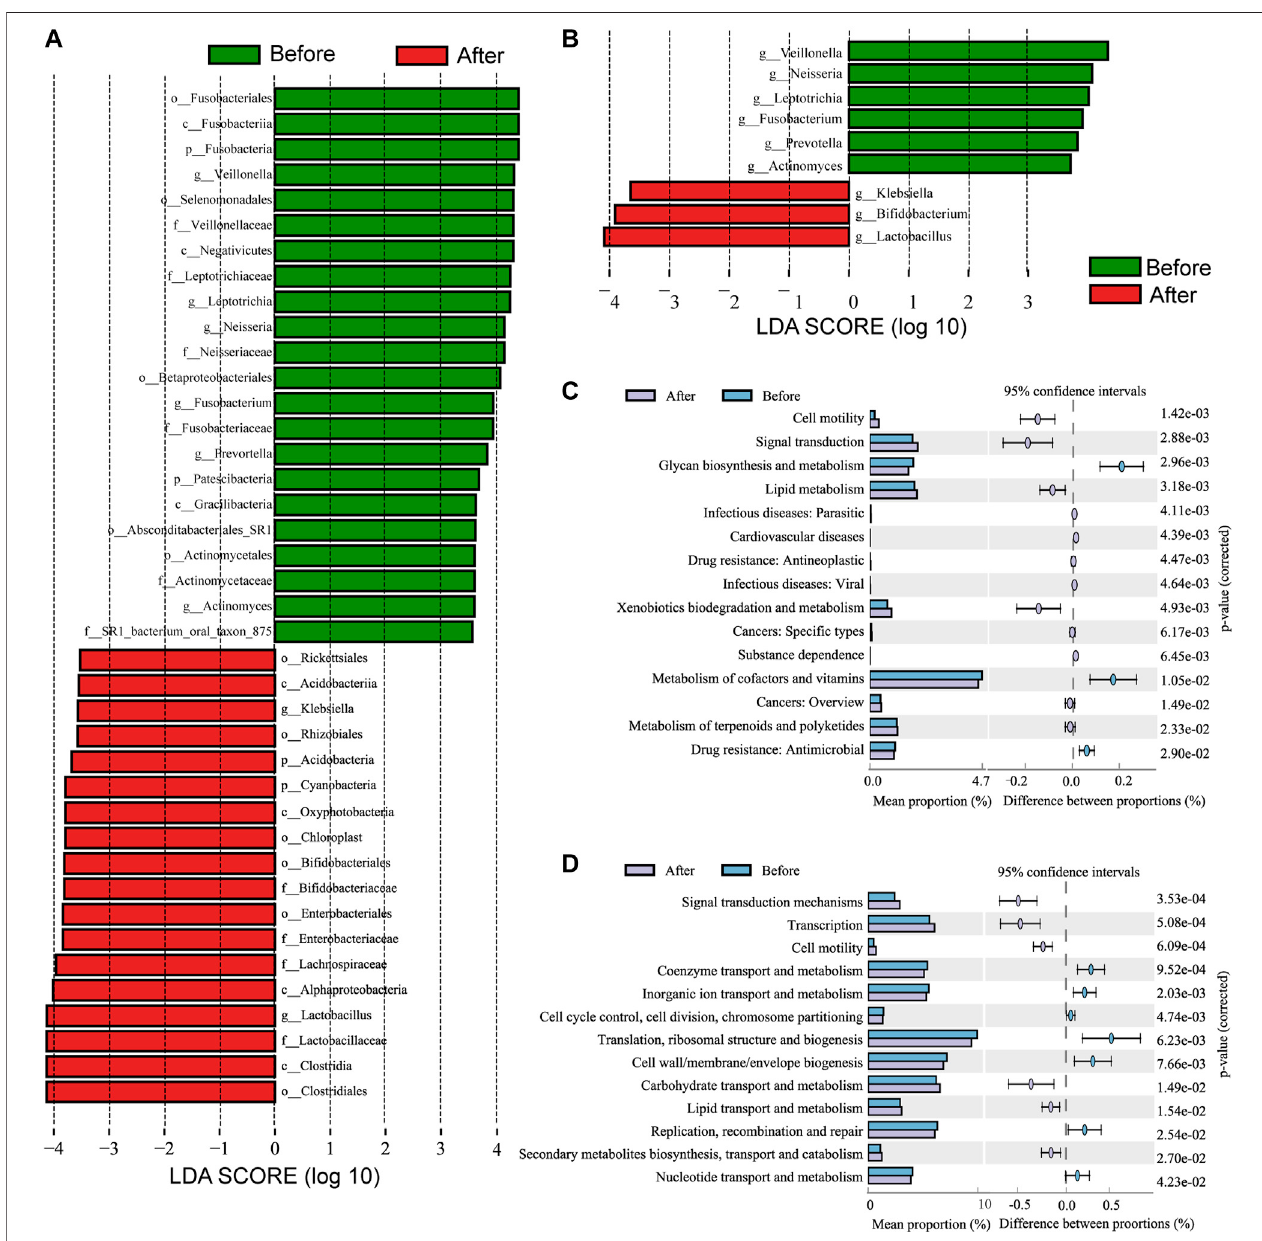
FIGURE3| Lineardiscriminantanalysiseffectsize(LefSe)andlineardiscriminantanalysis(LDA)analysischaracterizedmicrobiomesbetweenthebefore-andafter- LS capsule administration groups. (A) LDA scores showing the signi fi cant bacterial difference between the before- and after-administration groups. Only taxa with LDA scores of > 3.5 are presented. Pre fi x p_ phyla, c_ class, o_ order, f_ family, and g_ genus. (B) LDA scores showed a signi fi cant bacterial difference between the before- and after-administration groups at the genus level. (C) Signi fi cant Kyoto Encyclopedia of Genes and Genomes (KEGG) pathway at level 2 and (D) Cluster of Orthologous Groups ofproteins (COG) at level 2for thepharynx microbiome in thebefore- and after-administration groupsidenti fi ed using STAMPsoftware. InSTAMP, thedifferencesinabundancebetweenthePHandcontrolgroupswereanalyzedusingtheWhite t test.Multipletestcorrection:Benjamini – Hochbergfalsediscoveryrate ( p <